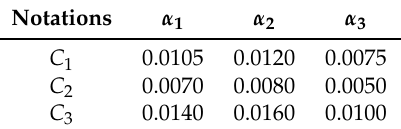
Table 1. Mobility coefficients.